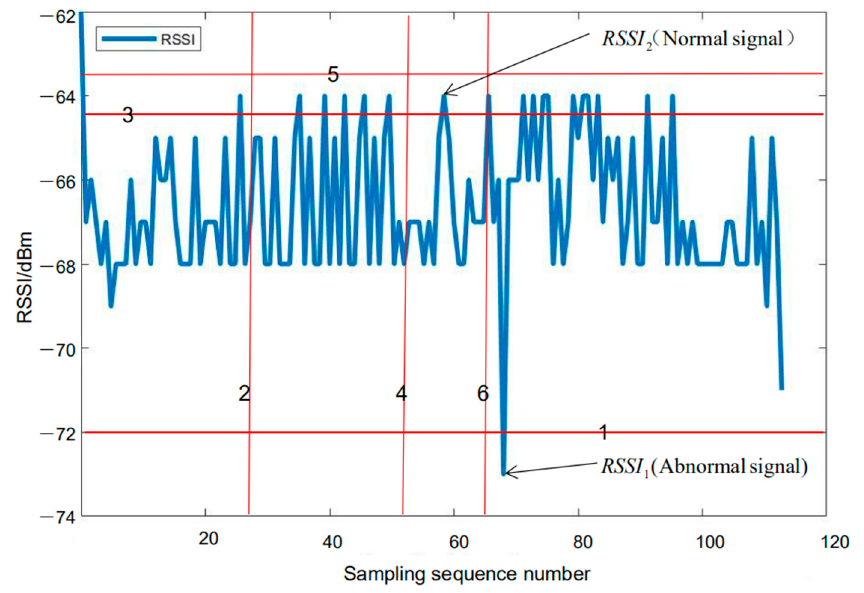
Figure 3. Isolation forest and spatial segmentation.